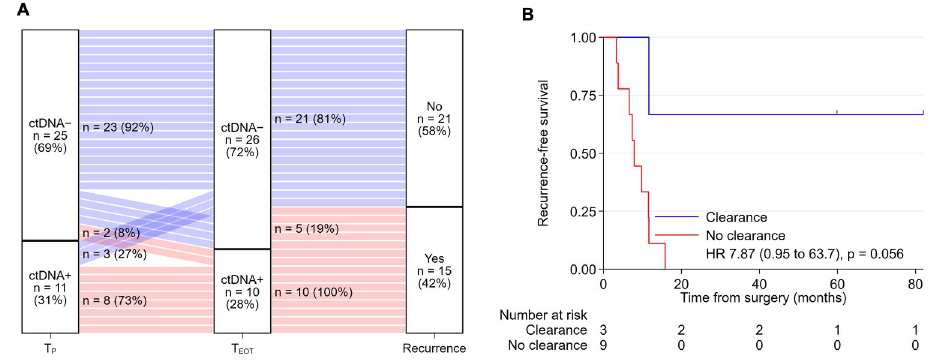
Fig 4. ctDNA dynamics with adjuvant chemotherapy and recurrence. (A) Sankey plot of ctDNA dynamics with adjuvant chemotherapy treatment and recurrence outcome for the 36 patients who had both postoperative (T P ) and end-of-treatment (T EOT ) ctDNA samples available for analysis. (B) Recurrence-free survival according to ctDNA clearance after completing adjuvant chemotherapy for patients with positive postoperative ctDNA. ctDNA, circulating tumor DNA.